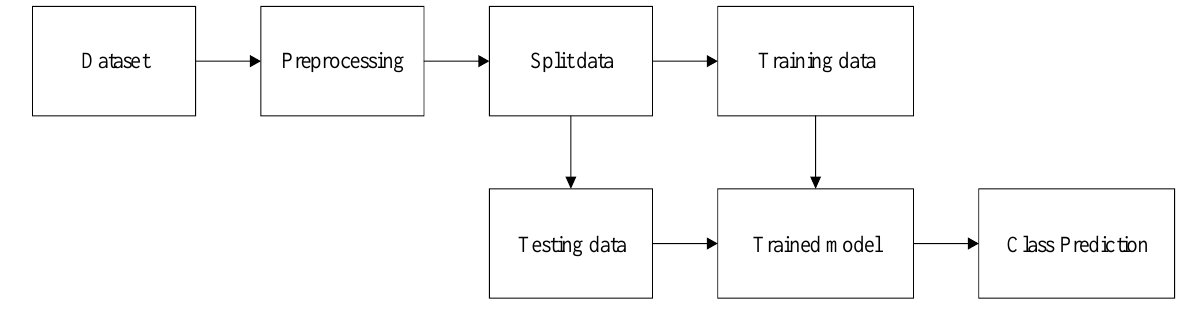
Figure 6. Flowchart of the proposed working methodology.